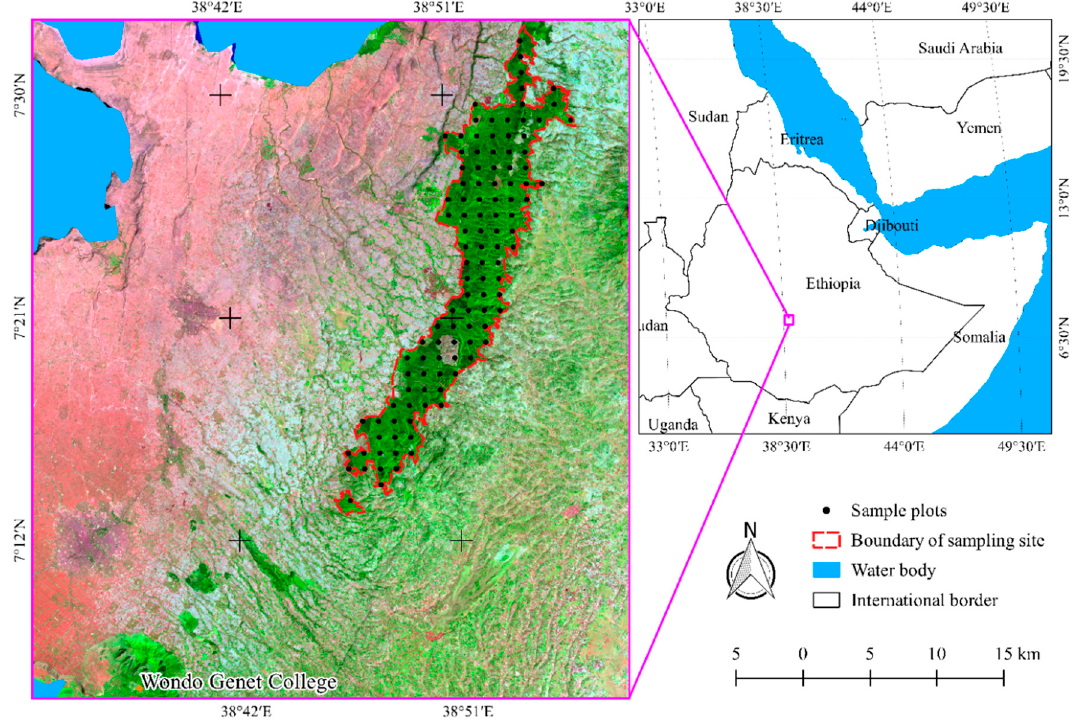
Figure 1. Location of the study area and distribution of the field sample plots (SPs). A band combination of SWIR-NIR-R (in the order of R-G-B) of L8 image was used to enhance the appearance of vegetated areas (in green).